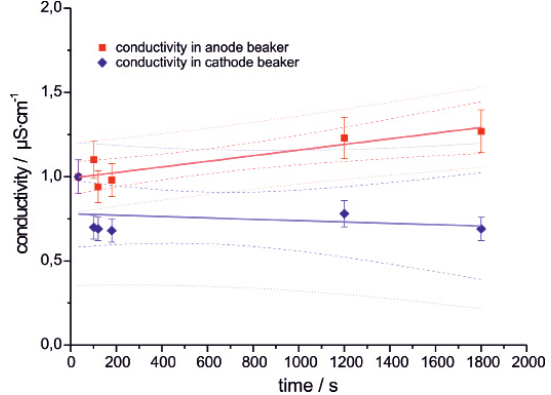
Figure 5. Exp. 1a: Transport of phenol from cathode to anodic beaker, conductivity measurement evaluated with a linear fit including 95% confidence (dashed) and 95% prediction (dotted) intervals.